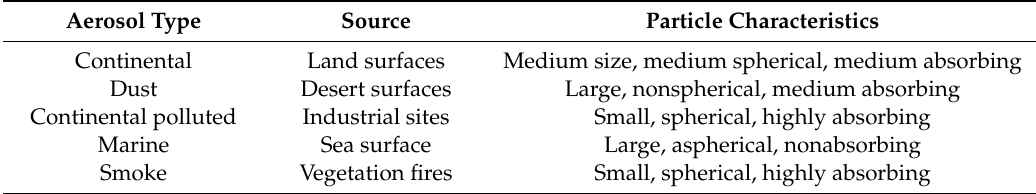
Table 2. Conventional names of the aerosol types